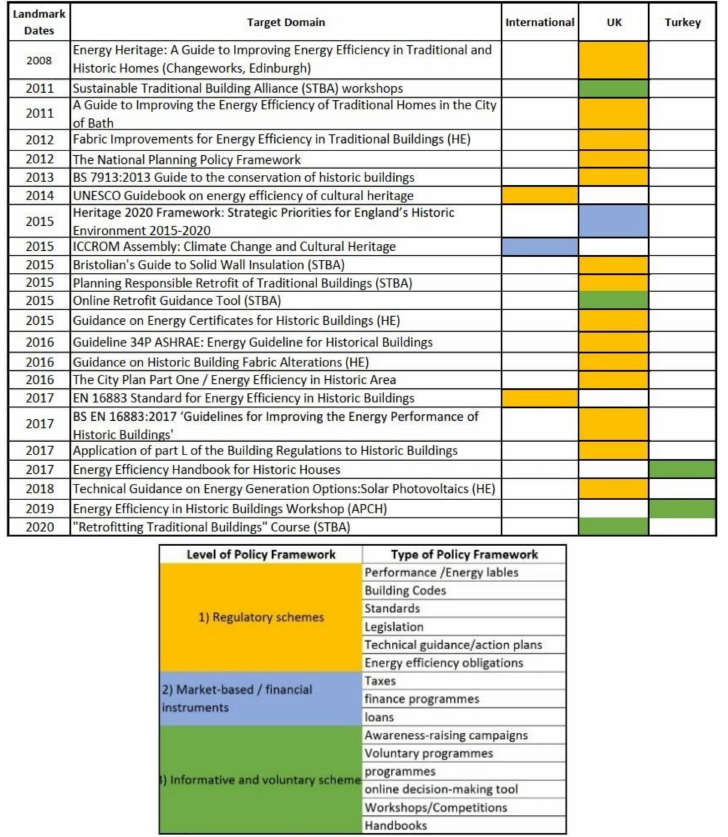
Figure 1. Comparison of the level of policy frameworks on energy e ffi ciency in historic